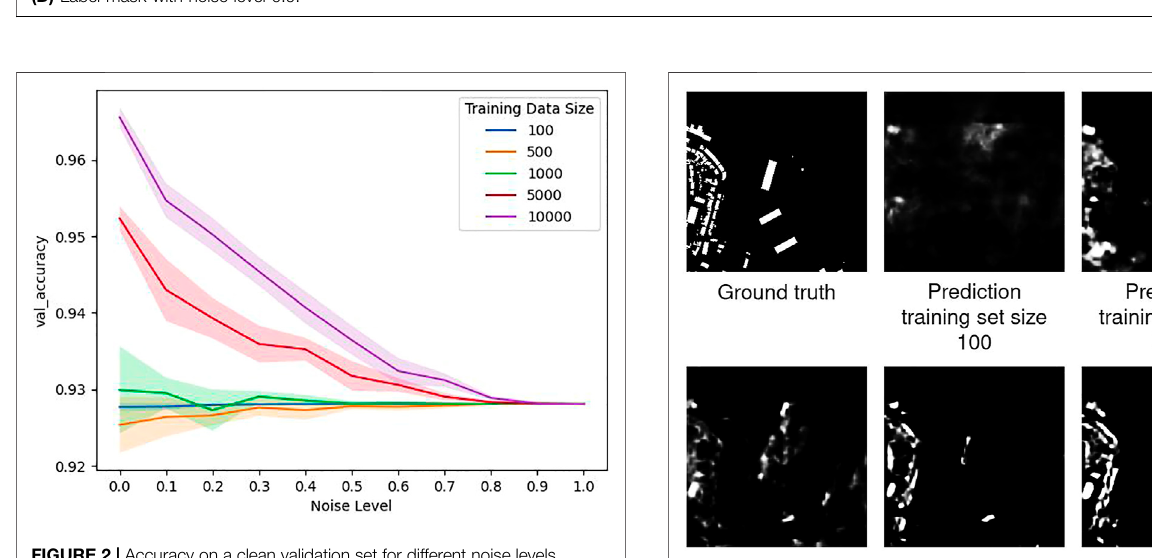
Frontiers in Remote Sensing |